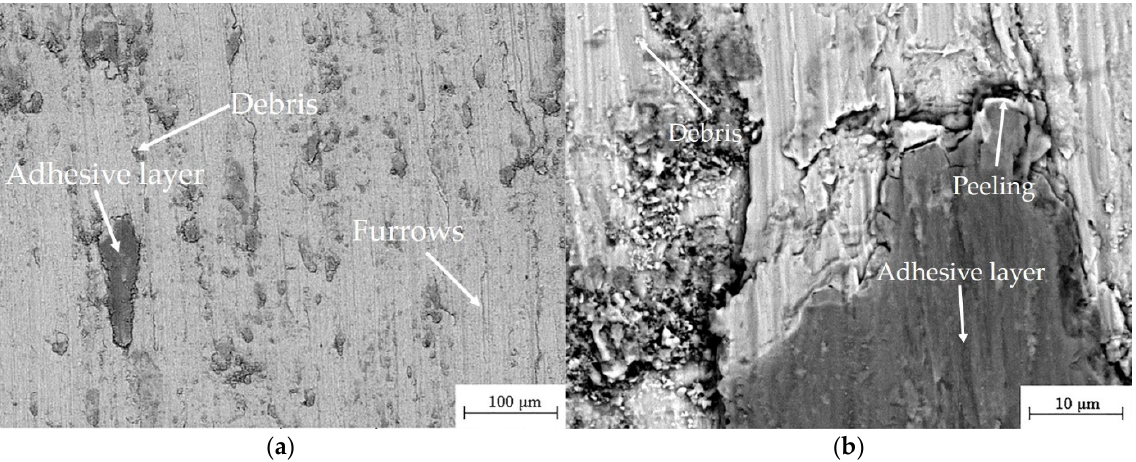
Figure 13. Wear scars of N80 counterparts corresponded to the CoCrFeNiMn HEA coating at 55 A plasma arc current after wear test: ( a ) global morphology, ( b ) magnified part.